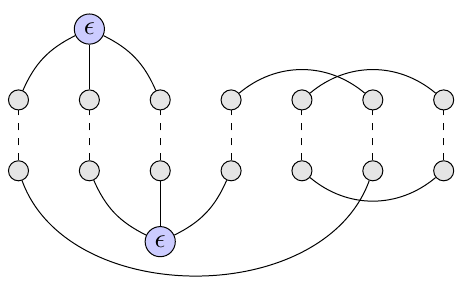
Figure 7 . Computing the inner product of two m = 7 states. The gray dots represent either a SO(3) index coming from either one or two B † operators. Solid lines represent contractions in the individual states, and dotted lines represent δ -tensors coming from (A.2). Calculating the inner product reduces to counting SO(3) traces and possibly computing a contraction of two (cid:15) -symbols, which can be accomplished